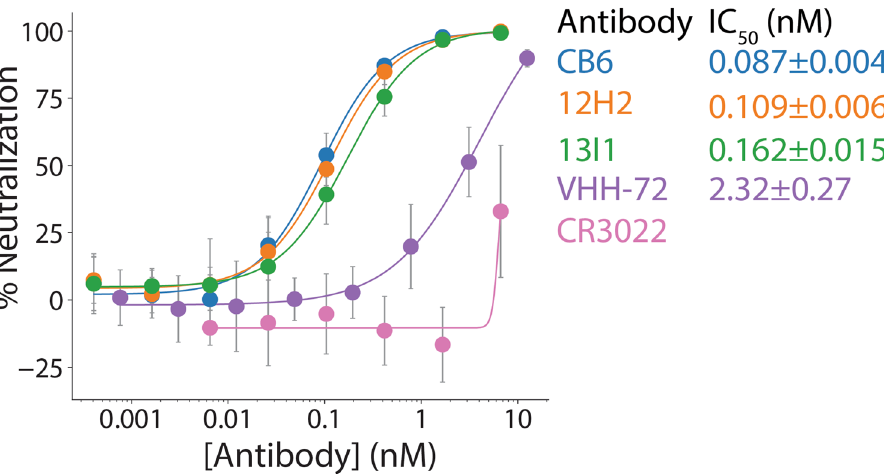
Figure 5. Isolated antibodies demonstrate potent neutralizing activity in a SARS-CoV-2 pseudovirus assay. Neutralizing activities of the high affinity antibodies (12H2 and 13I1) are shown relative to a potent neutralizing control antibody (CB6) and two control antibodies with moderate (VHH-72) and weak (CR3022) neutralizing activity. A lentivirus-based SARS-CoV-2 pseudovirus assay was employed, and the relative luciferase signal was measured 48 h post infection. Half-maximal inhibitory concentrations (IC 50 ) values are reported. These data are averages of three repeats, and the error bars are standard